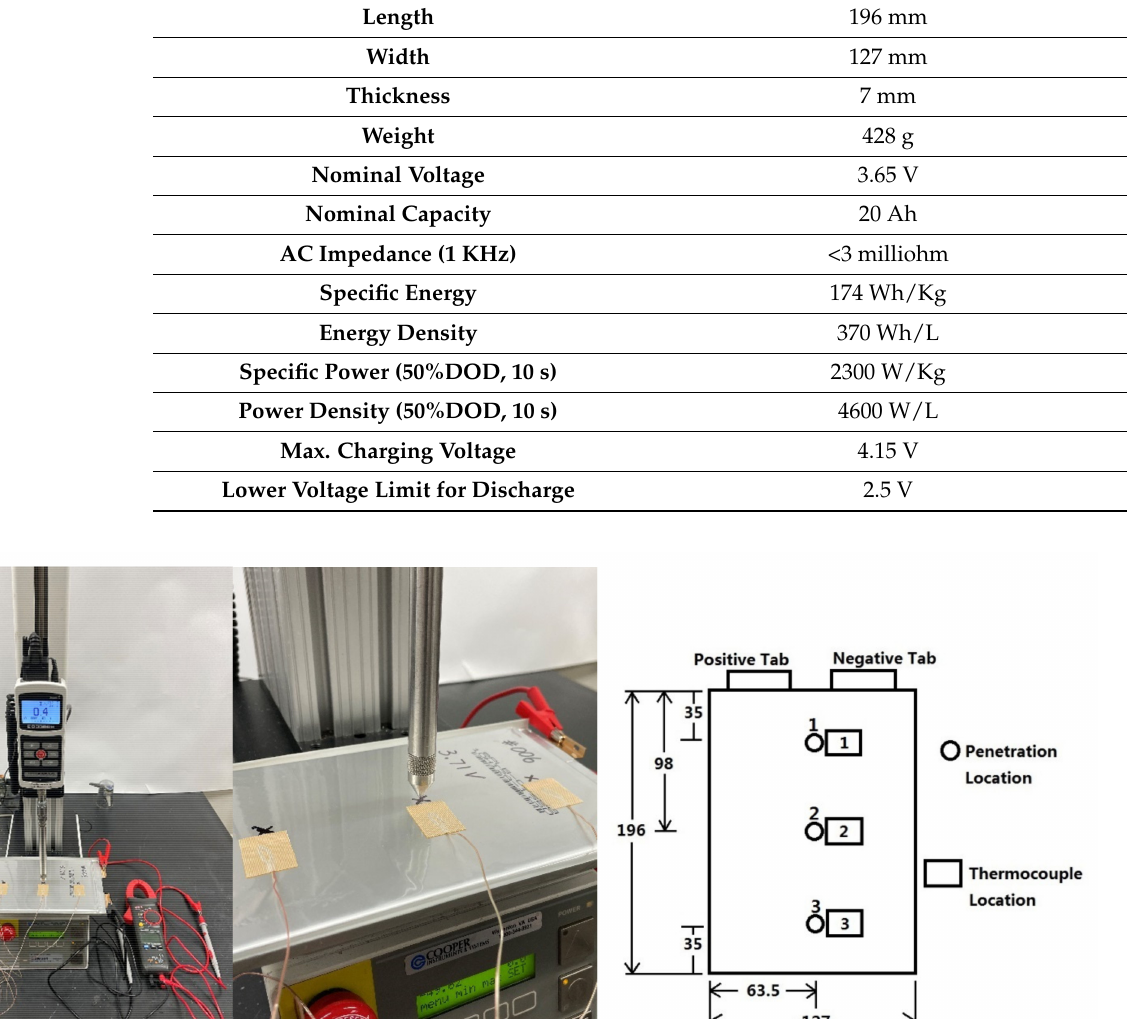
Table 1. Specifications of EiG ePLB-C020 Battery Cell.